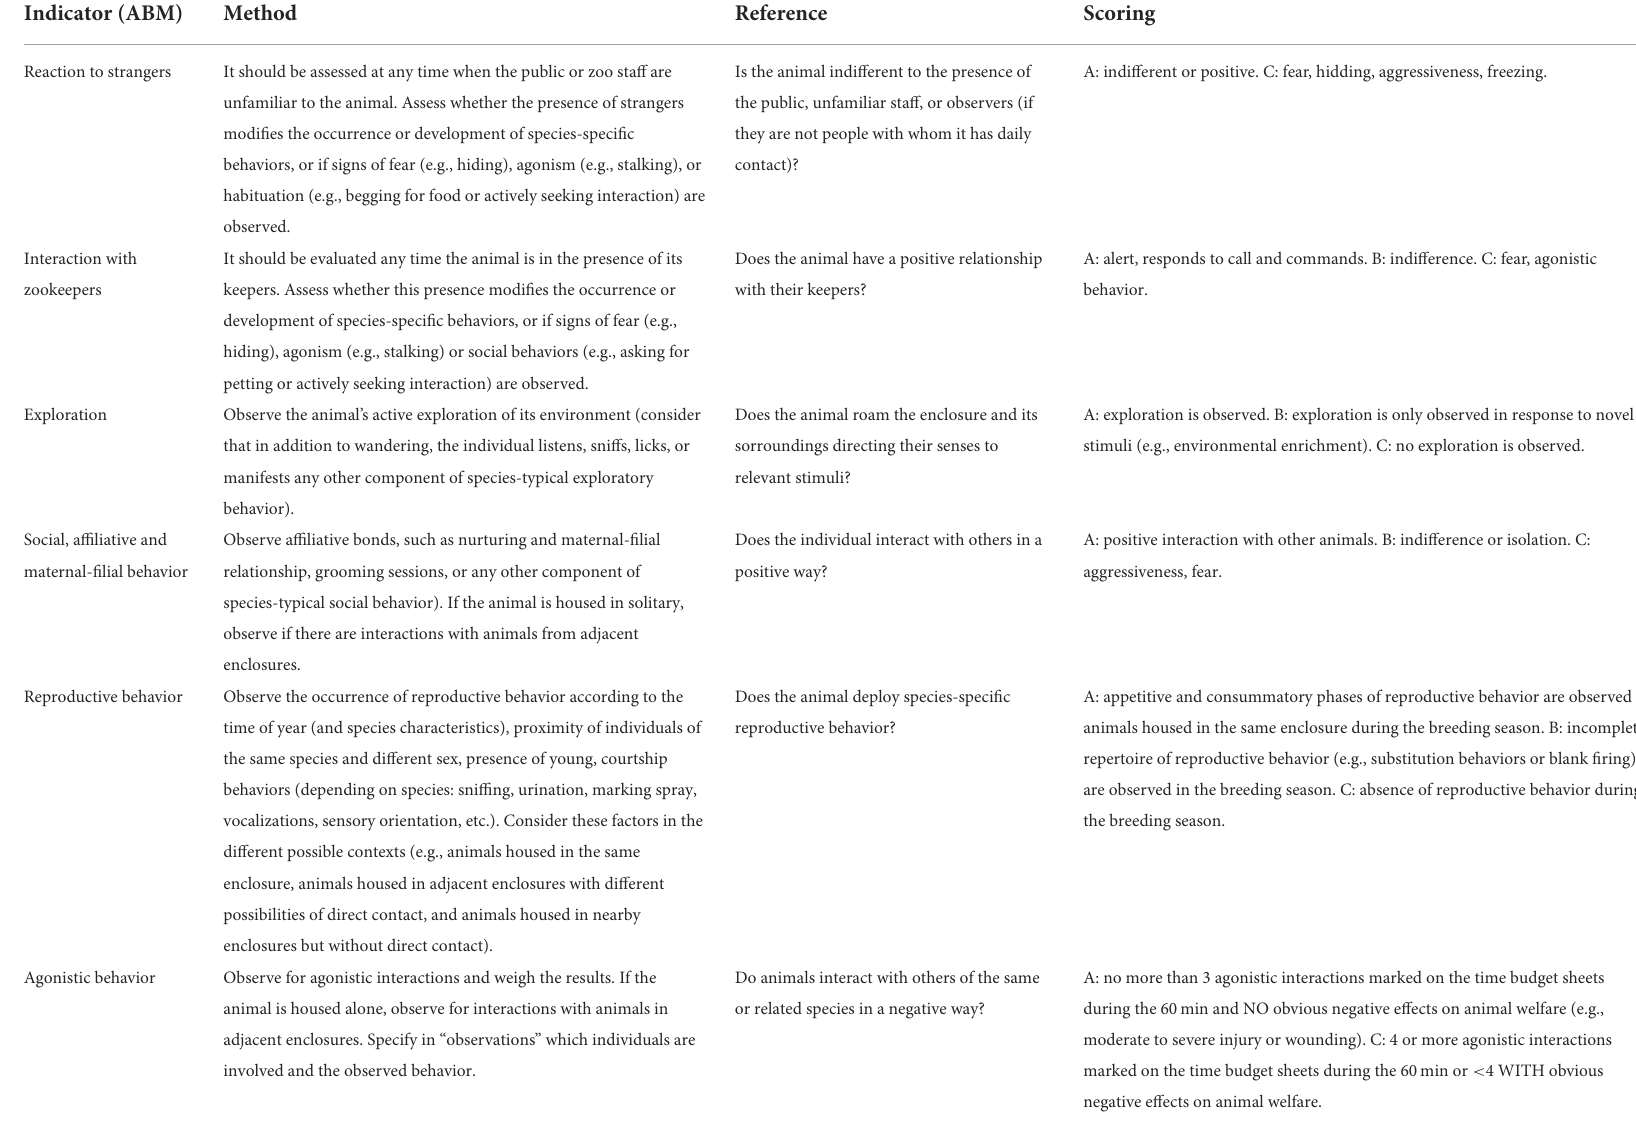
TABLE 8 Summary of the most relevant information that is provided in the user’s manual for assessing behavior and mental domain